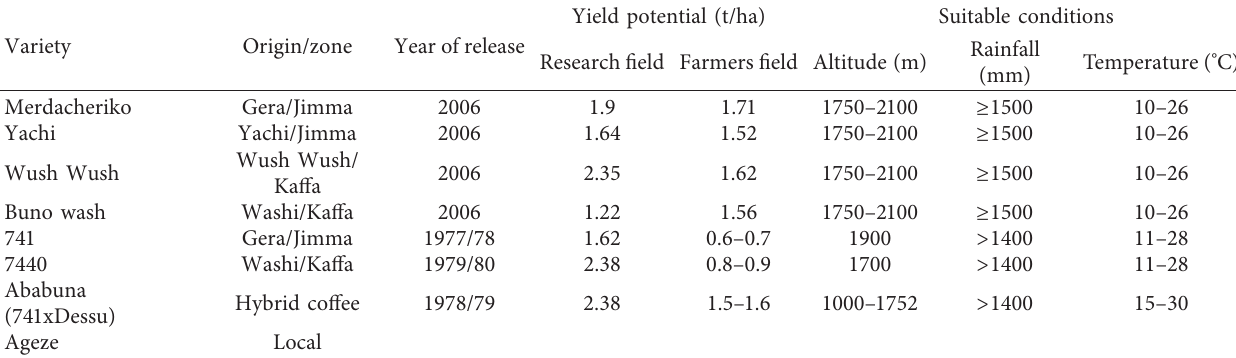
Table 1: Descriptions of coffee varieties used in the